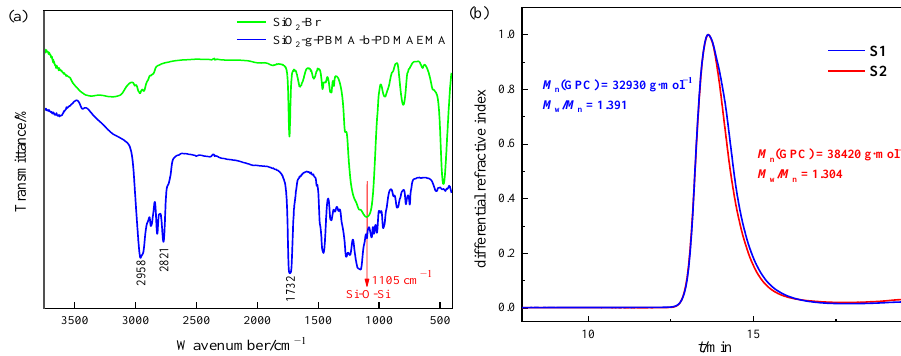
Figure 2. ( a ) IR spectra and ( b ) GPC curves of SiO 2 -g-PBA-b-PDMAEMA.